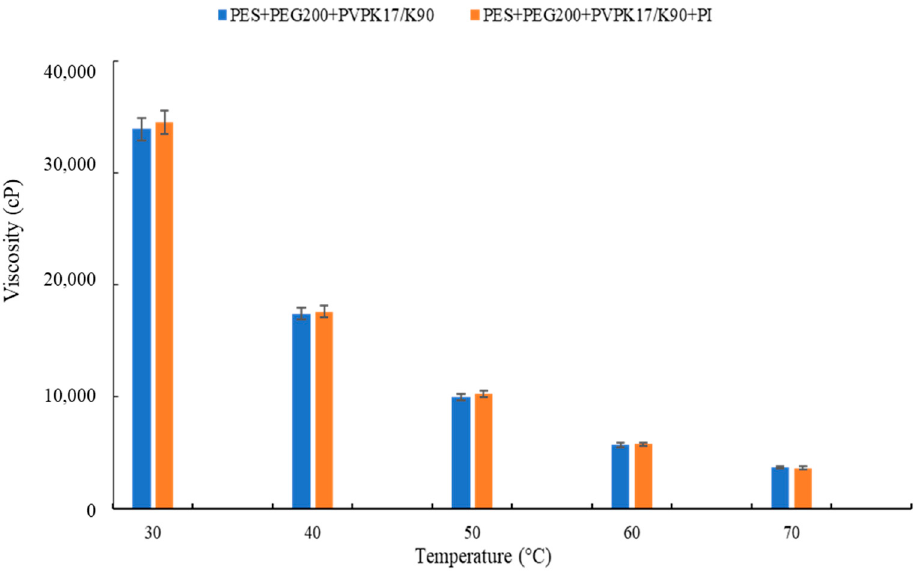
Figure 4. Viscosity of the polymeric dope solutions.